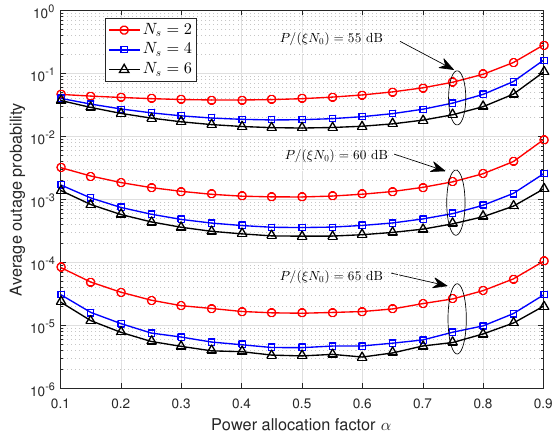
Figure 6. The effect of power allocation factor α on the average outage probability with different numbers of relays.